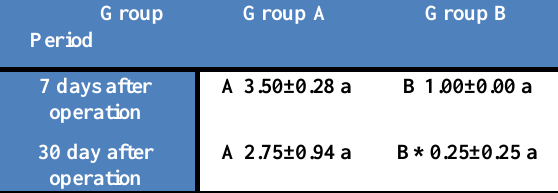
Means with different small letters in the same column differ significantly (P<0.05). Means with different capital letters in the same row differ significantly (P<0.05). *significant at the level of (P < 0.05). Table, 4: Means± SE for both two groups according to histopathological grades of adhesions. Scores. Group Group A Group B Period 7 days after A 2.75±0.50 a operation B* 1.00±0.81 a operation